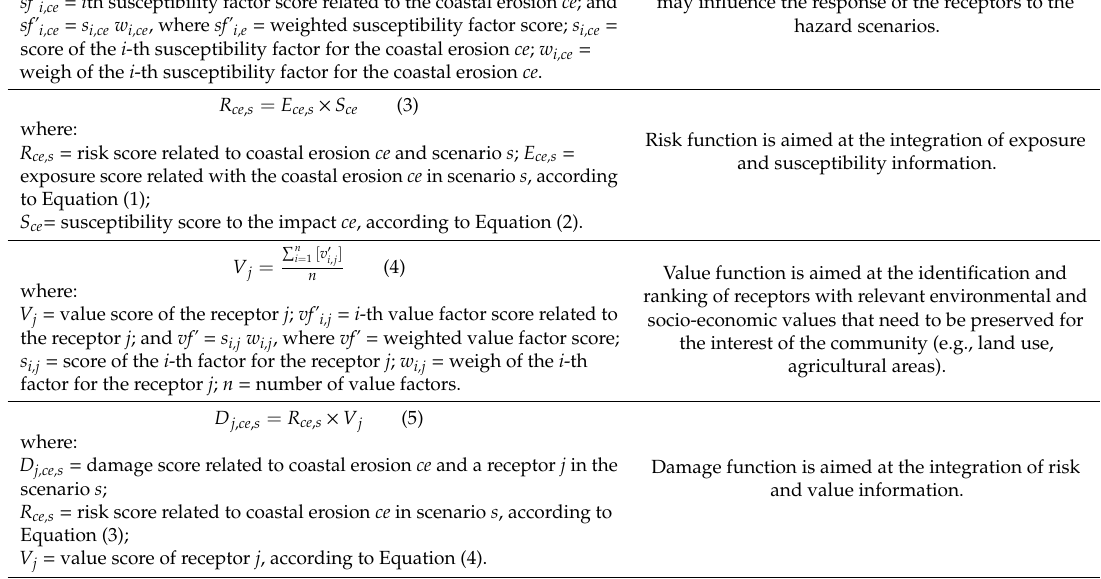
Exposure function is aimed at the relative ranking of areas potentially exposed to changes in coastal erosion stressors. It integrates information about the hazard metrics influenced by climate change (i.e., wave height and bottom stress, Paragraph 3.2), the presence of artificial protections and the distance from